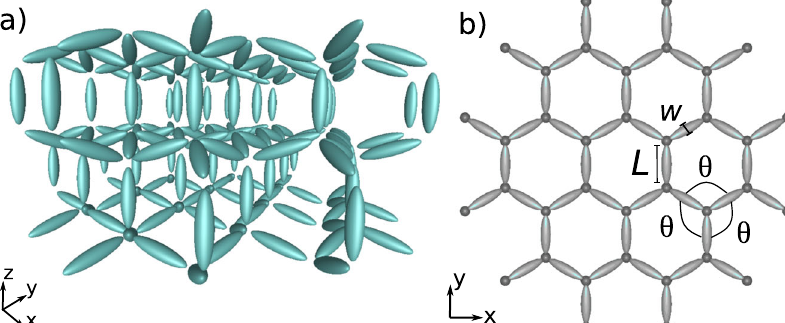
Fig. 1 3DASI lattice. a 3D Illustration of the 3DASI lattice, and b the top view. The length of the ellipsoids L and maximal width w as well as the angle between the ellipsoids θ are depicted in ( b ). The circles between the ellipsoids are the cross-section of ellipsoids pointing in or out of the plane, as a consequence of the chosen top